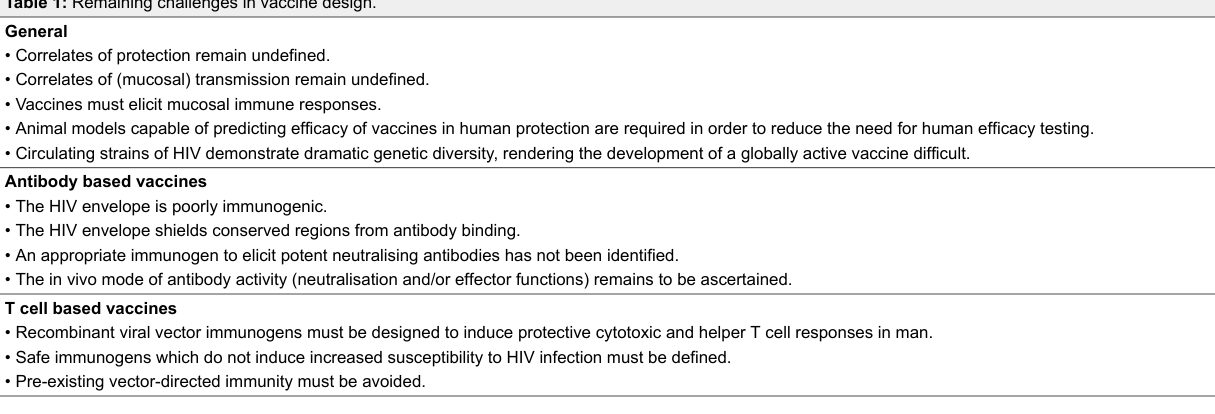
Table 1: Remaining challenges in vaccine